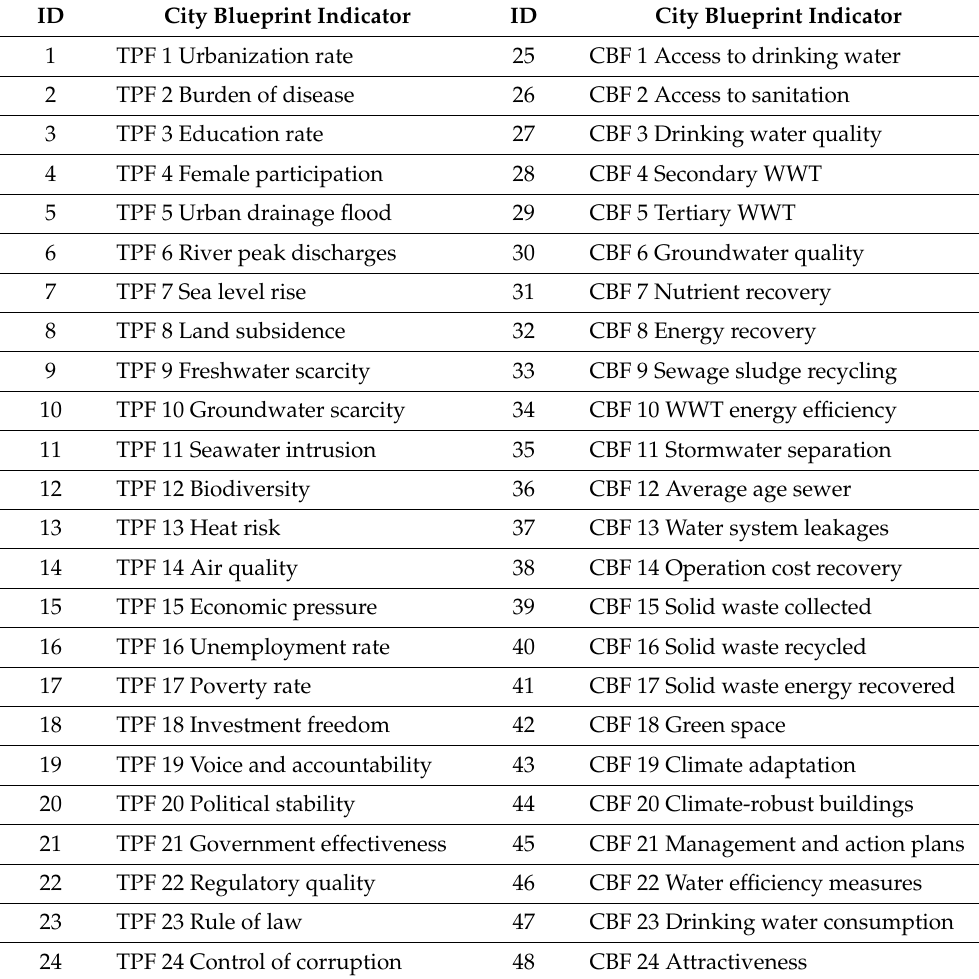
Table 2. Node numbers (ID) assigned to indicators.